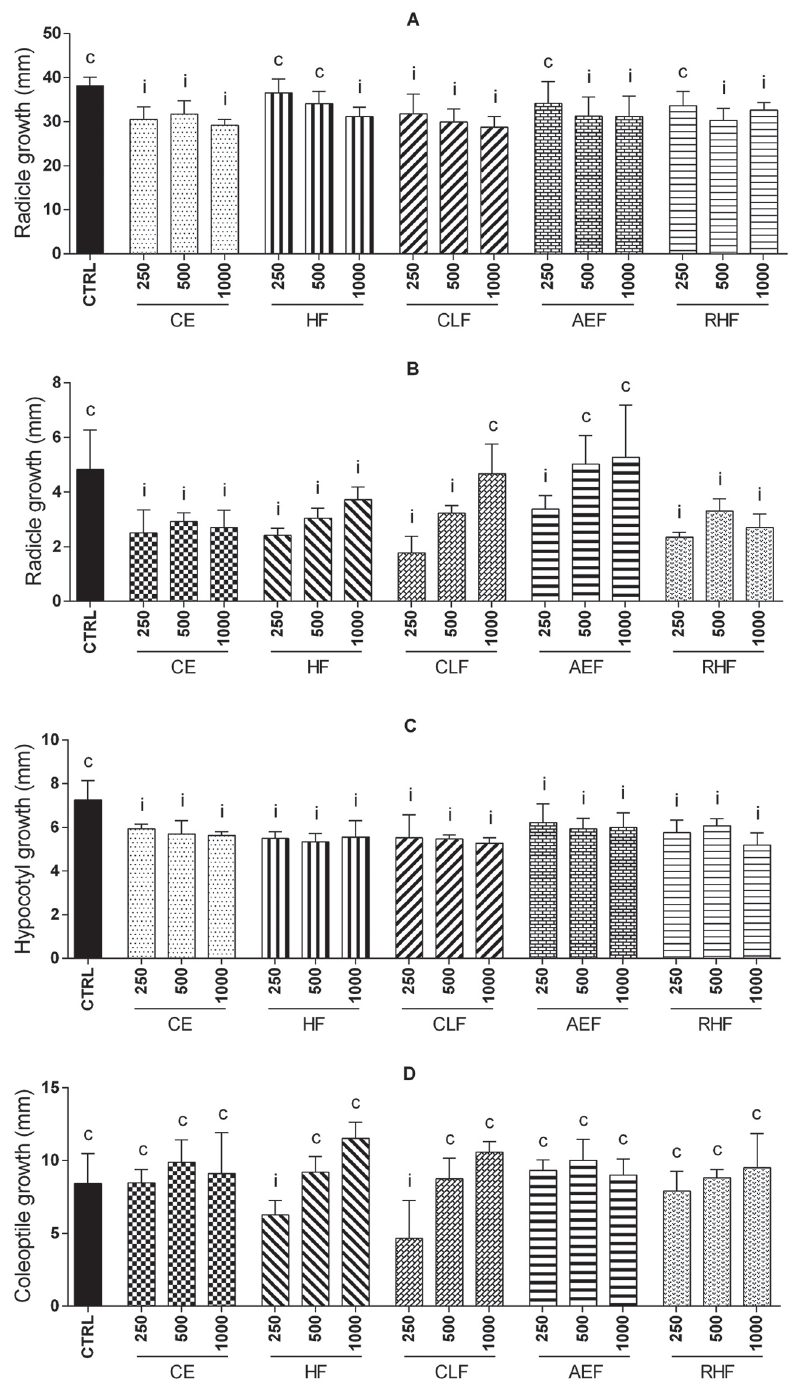
FIGURE 2 - Root growth of L. sativa (A and C) and A. cepa (B and D). Treatment means differ significantly (p< 0.05) when compared to control means i inhibiting or e stimulating root growth by Scott-Knott test. Treatment means do not differ significantly from c control